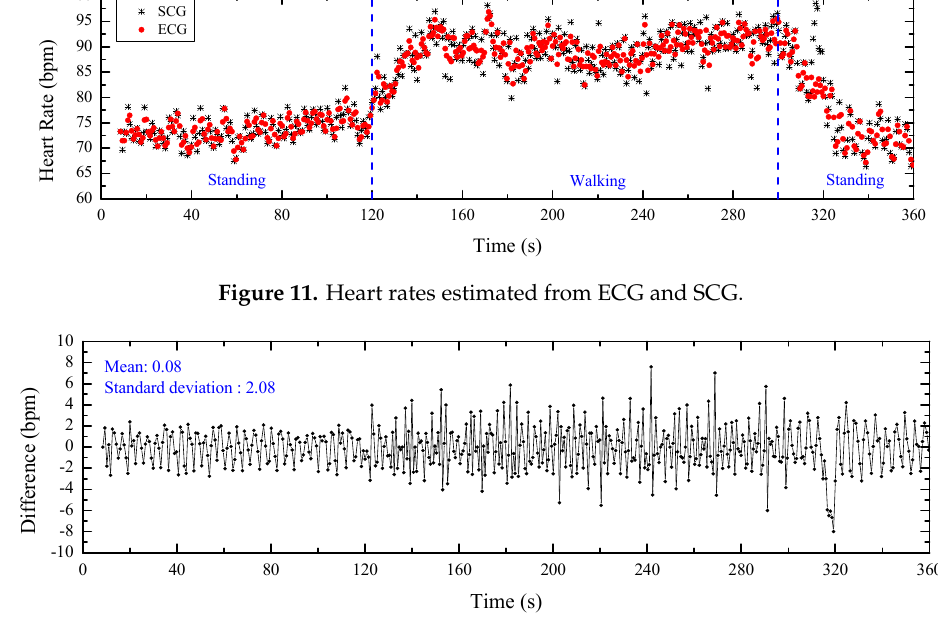
Figure 12. Heart rate difference between ECG and SCG.